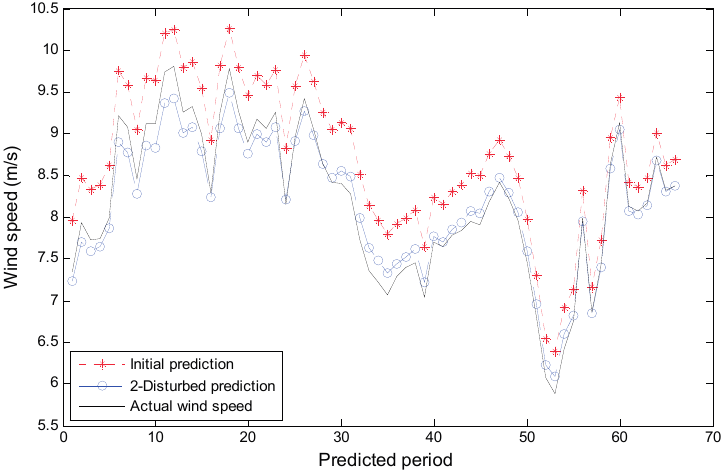
Figure 6. Wind speed forecasting results of the quadratic polynomial generating model when Rayleigh number equals 0.7.